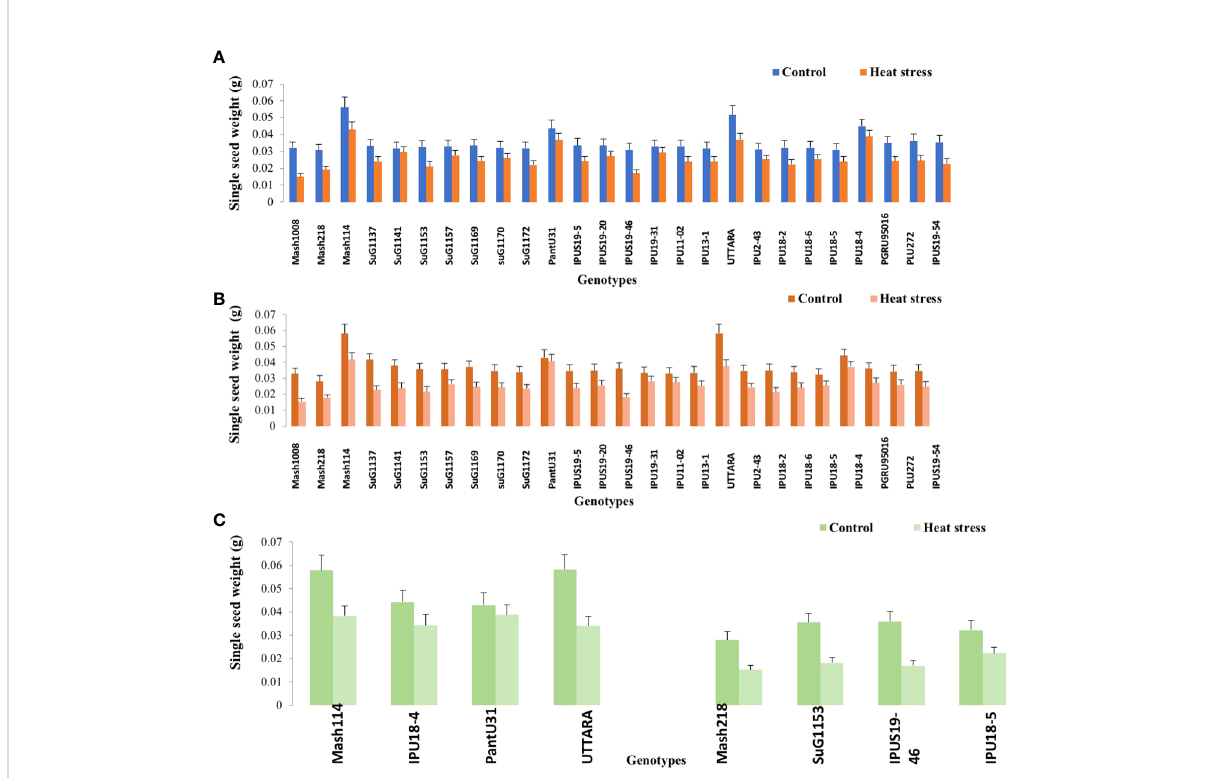
FIGURE 4 Single seed weight of Urdbean genotypes under control (normal-sown; Control) and heat stress environment during 2018 (A) , 2019 (B) and in controlled environment of growth chamber ( C ;GC). LSD values (P < 0.05); genotype × treatment: 0.0023 (2018), 0.0021 (2019), 0.0018 (GC). Values are means + SE. (n = 3).